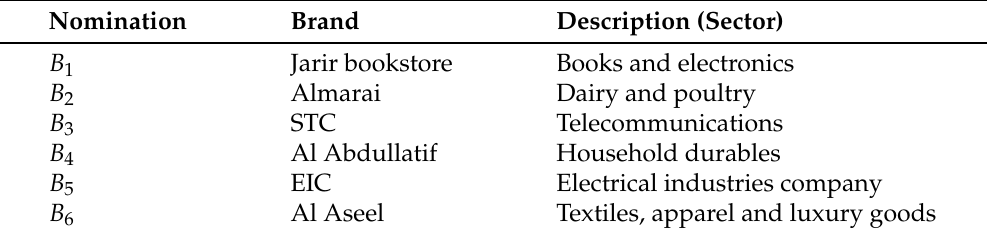
Table 1. Some top Saudi brands. Nomination Brand Description